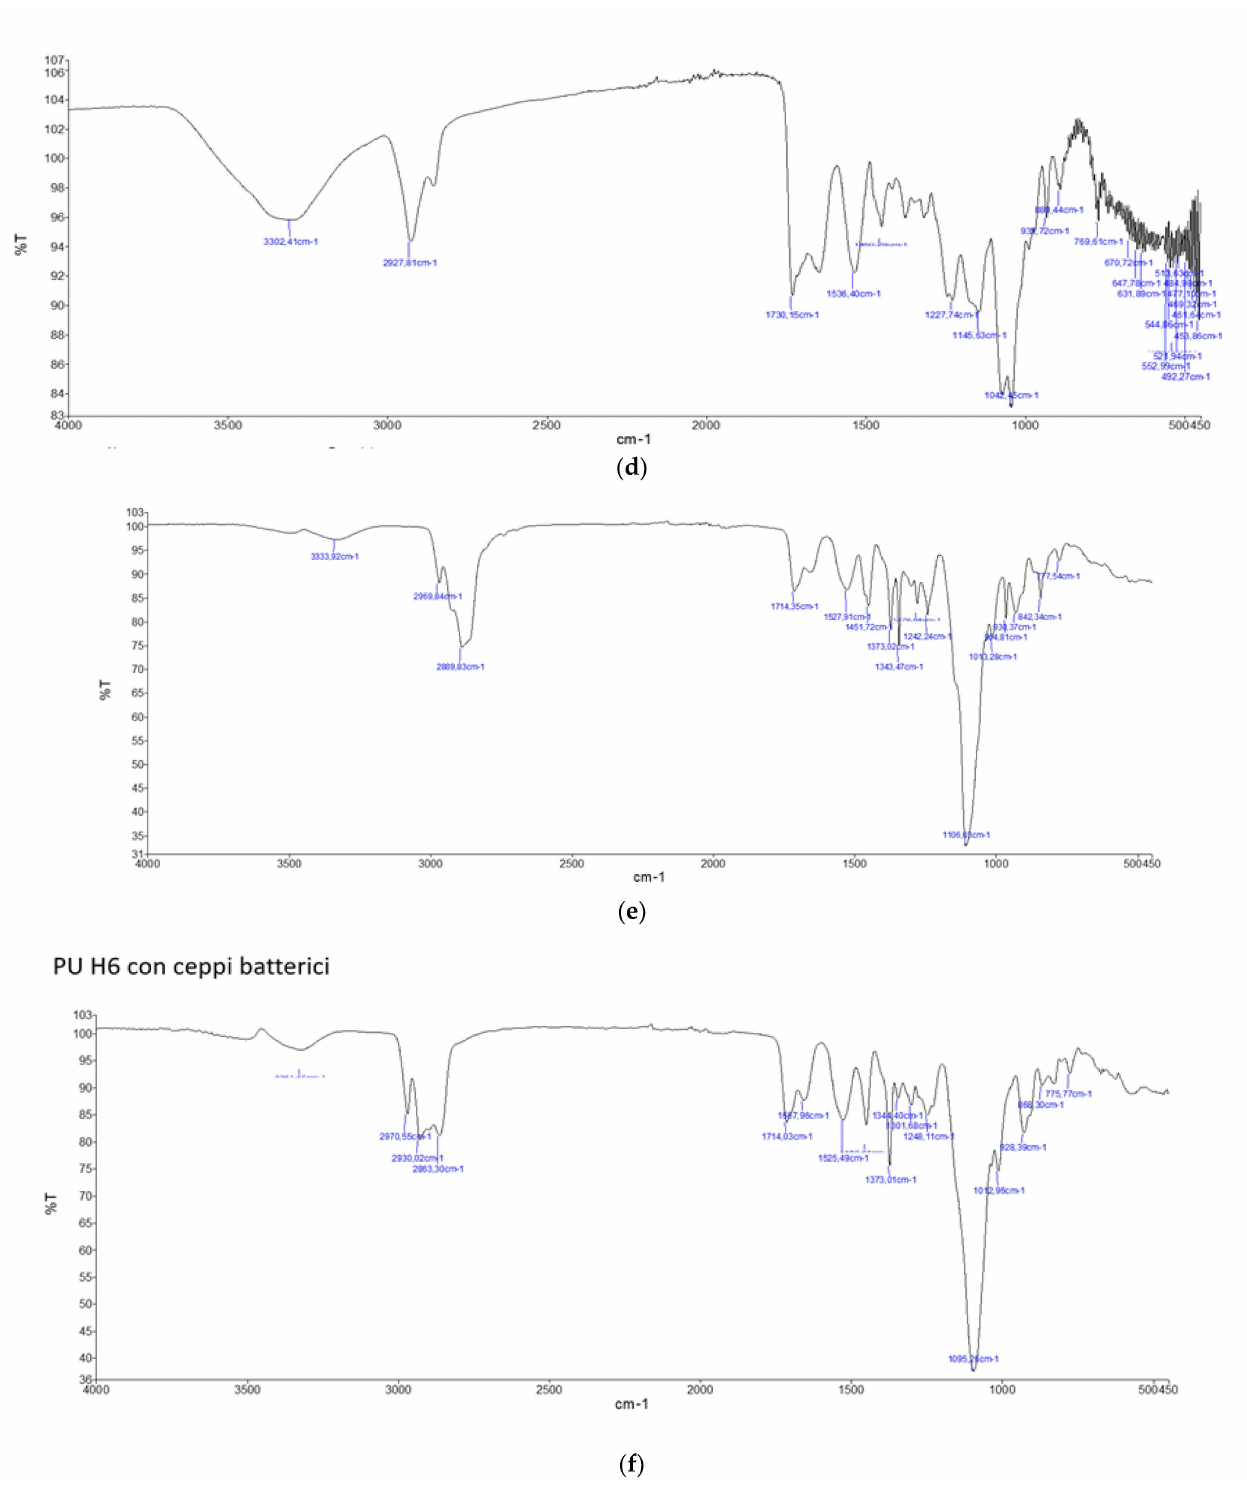
Figure 5. FT-IR spectra of polyacrylic resin AC 32 and polyurethane PU MW2 controls ( a , b ) and after 7 days of incubation with fungi ( c , d ). FT-IR spectra of polyurethane resin PU H6 control ( e ) and after 7 days of incubation with P. aeruginosa ATCC 9027 ( f